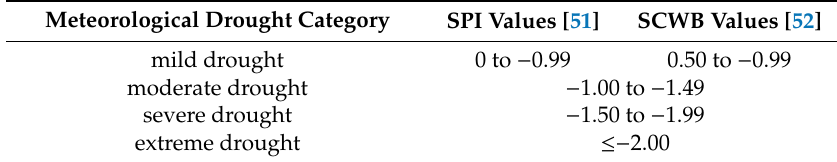
Table 2. Classification of meteorological drought according to standardized precipitation index (SPI) and standardized climatic water balance (SCWB)